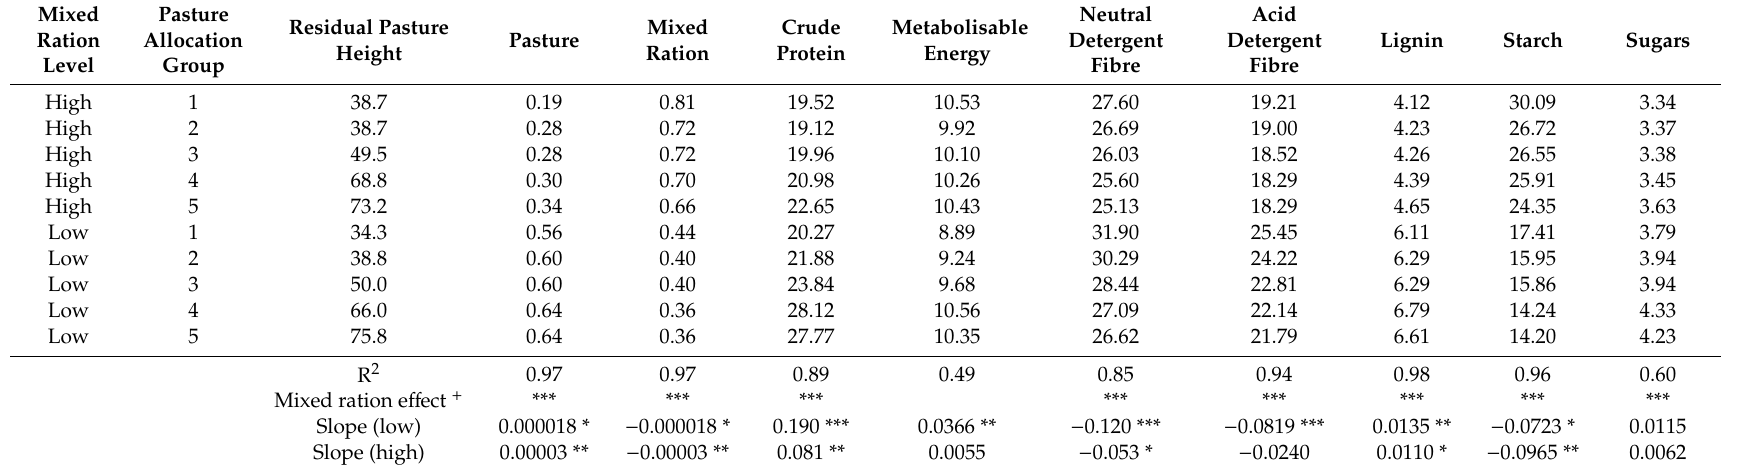
Table 8. Proportion of pasture, mixed ration and nutrient (% dry matter (DM)) and metabolisable energy (MJ / kg DM) content of the total diet for each treatment group. Mixed Pasture Residual Pasture Ration Allocation Level Group